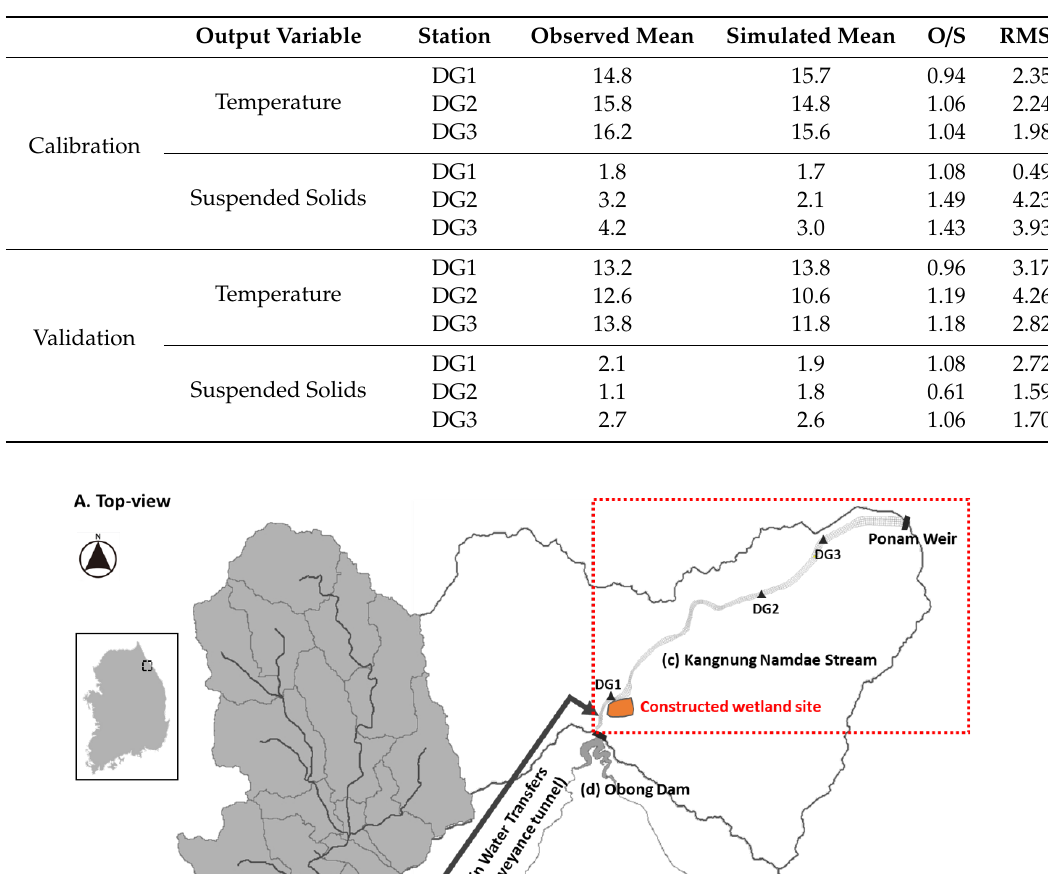
Table 2. Fit of the EFDC model.